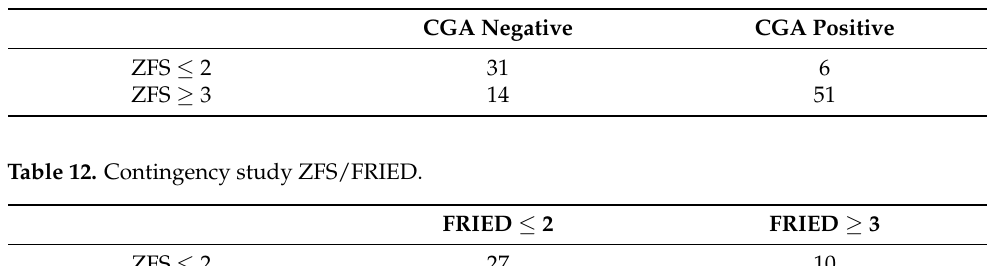
Table 11. Contingency study ZFS/CGA.